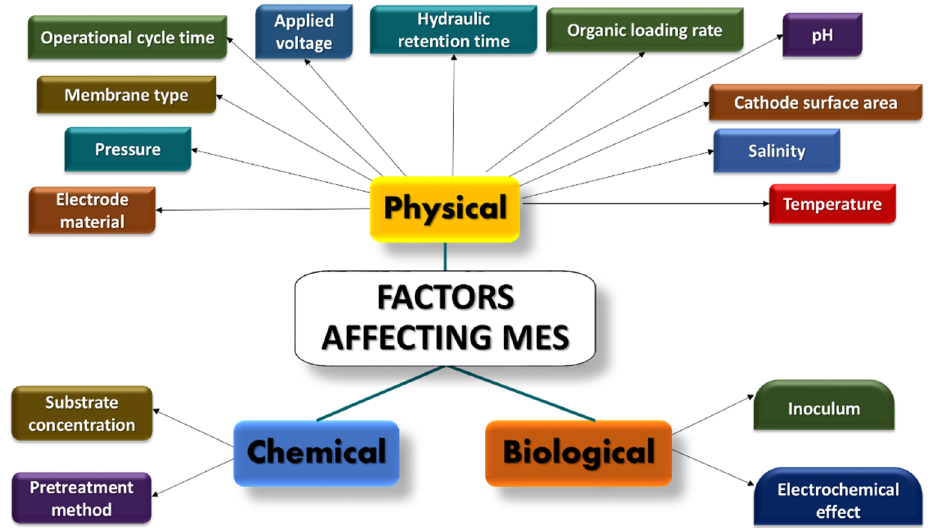
Figure 4. Several physical, chemical and biological factors affecting